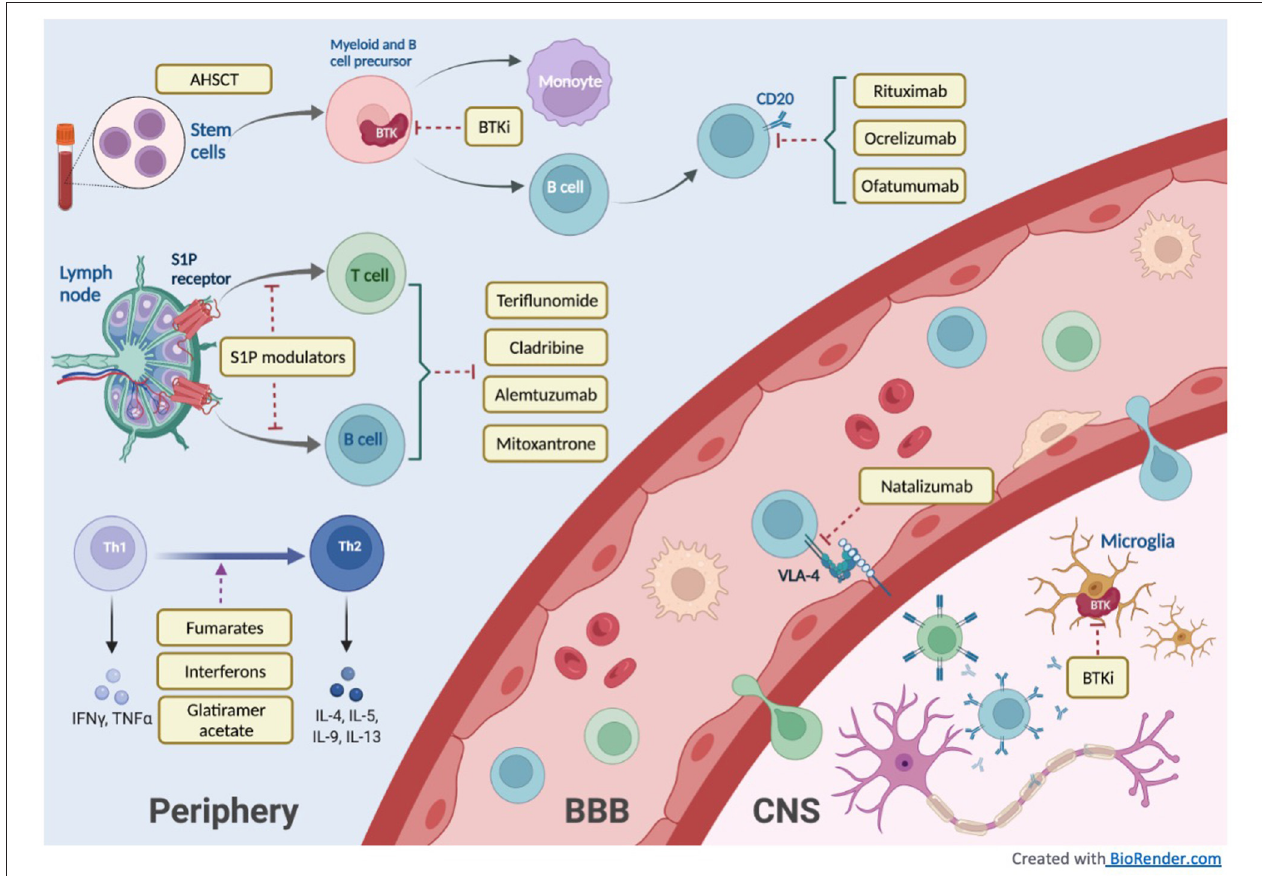
FIGURE 1 | DMT mechanism of